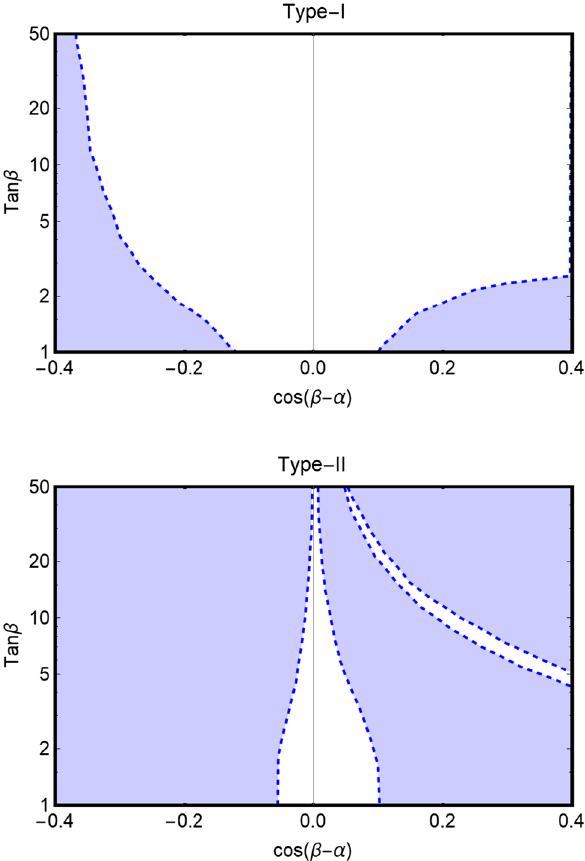
Fig. 1 Limits on deviations (the white regions are allowed) from the alignment limit in the for Type-I (upper panel) and Type-II (bottom panel)